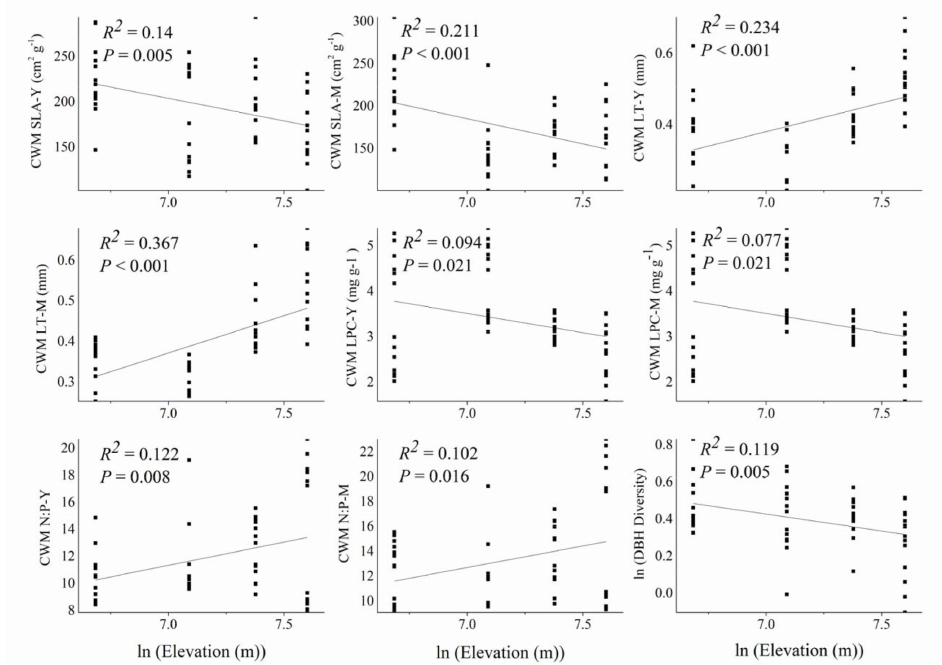
Figure 2. Bivariate relationships between elevation (dependent) and exogenous (independent) variables ( n = 56). Only significant relationships are shown ( p < 0.05). CWM, community-weighted mean; FDvar, functional diversity; SLA-Y, specific leaf area of young leaf; LT-Y, leaf thickness of young leaf; LPC-Y, leaf phosphorus concentration of young leaf; N:P-Y, N:P ratio of young leaf; SLA-M, specific leaf area of mature leaf; LT-M, leaf thickness of mature leaf; N:P-M, N:P ratio of mature leaf; DBH: diameter at breast